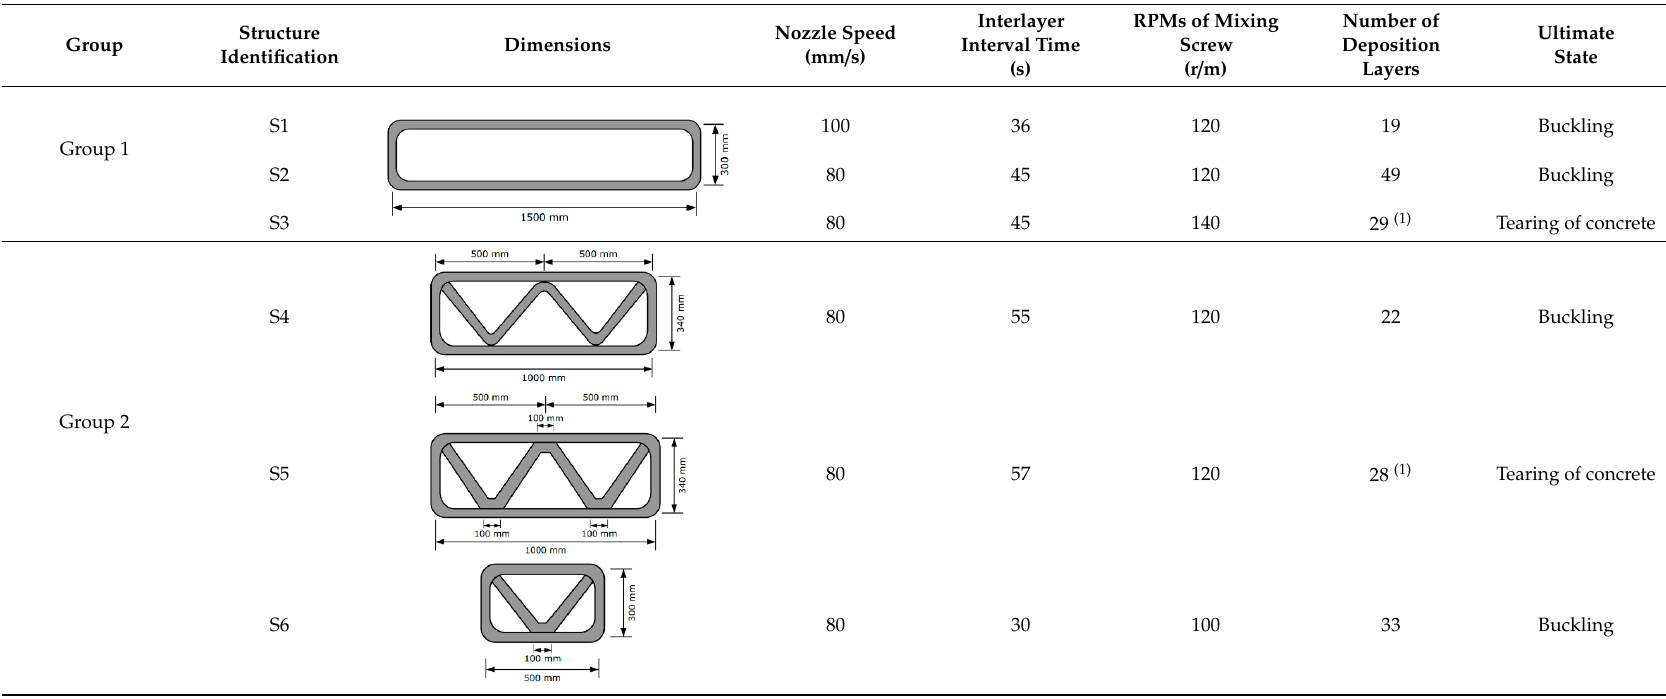
Table 1. Details of the printed structures.